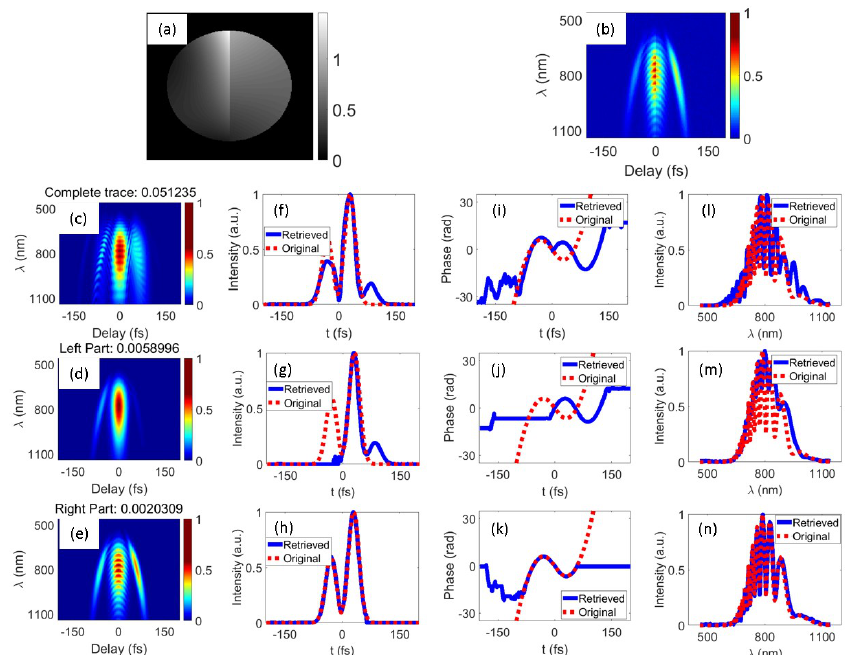
Figure 4. Numerical reconstruction from a partially polluted THG − FROG trace of a double Gaussian chirped pulse. ( a ) simulated poor spatial distribution, ( b ) polluted FROG trace, ( c – e ) reconstructed traces, ( f – h ) amplitude of reconstructed pulses, ( i – k ) phase of reconstructed pulses, and ( l – n ) spectral intensity distributions of the reconstructed